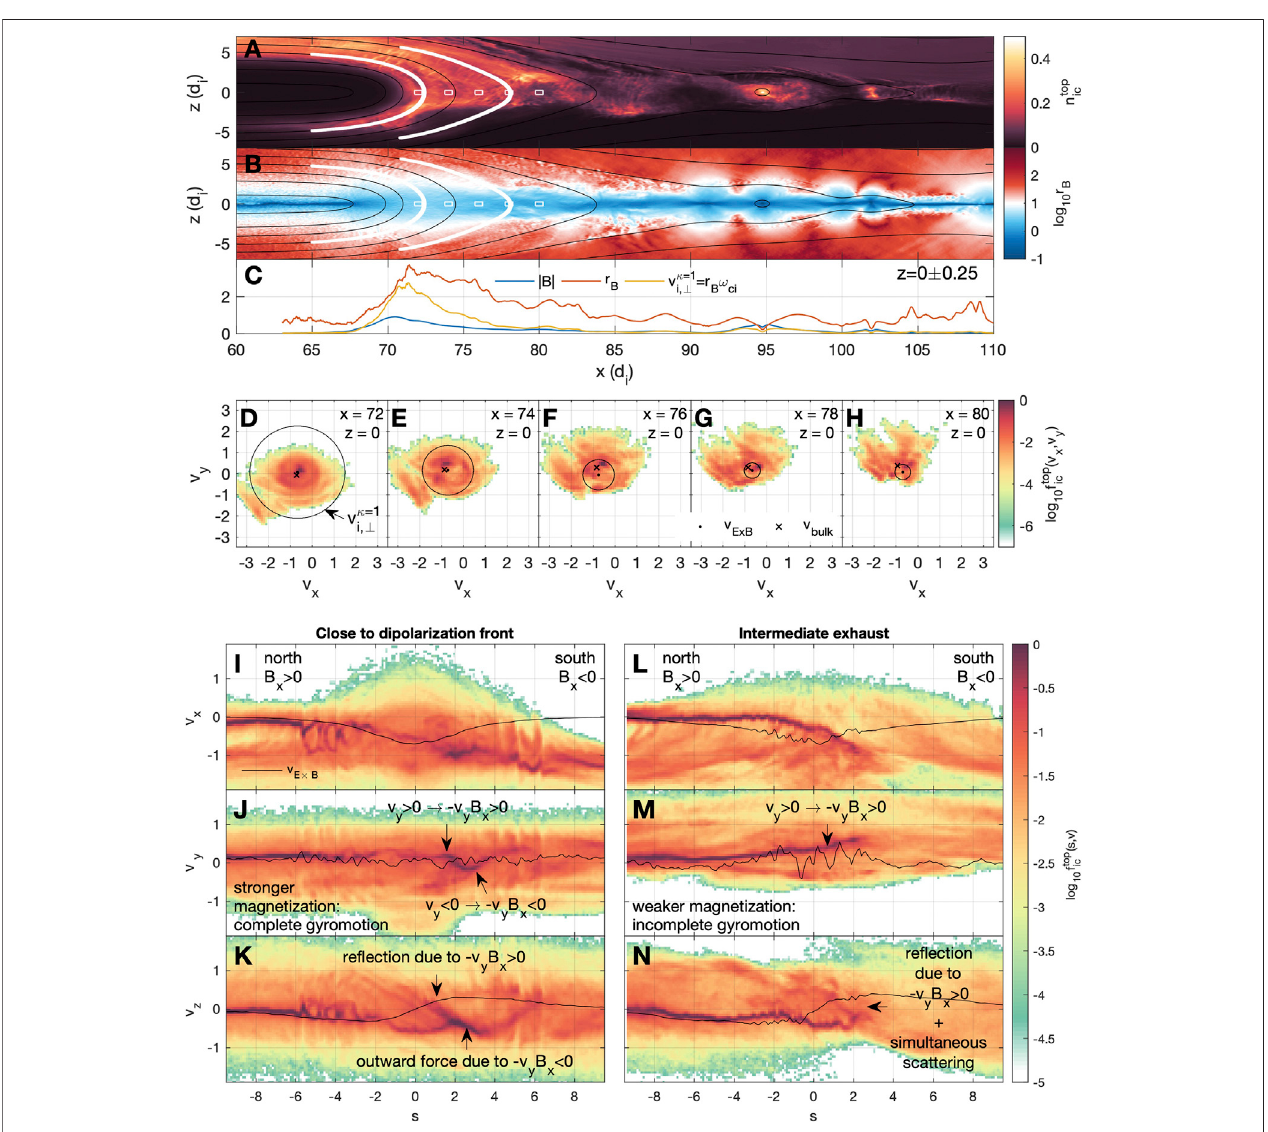
FIGURE 6 | (A) Density of initially cold ions originating from the north, n top ic . (B) Magnetic fi eld curvature radius log 10 r B . (C) Magnetic fi eld magnitude | B |, r B , and v κ (cid:1) 1 i , ⊥ (cid:1) r B ω ci . (D – H) Reduceddistributions f top ic ( v x , v z )at z (cid:1) 0,andsixdifferent x ,markedbywhitesquaresin (A,B) .Thecross ’ × ’ showsthebulkvelocity,thedot ’ · ’ shows v E × B , and the larger circle shows v κ (cid:1) 1 i , ⊥ , centered on v E × B . (I – N) Reduced distributions f ( s , v ) along the two different fi eld lines marked as white lines in (A, B) . Panels (I – K) corresponds tothe fi eldlines locatedfurthest downstream. The black lineshows v E × B . The s isthelength alongthe fi eldline, where s (cid:1) 0corresponds to z (cid:1) 0,and s > 0 ( s < 0) corresponds to z < 0 ( z >